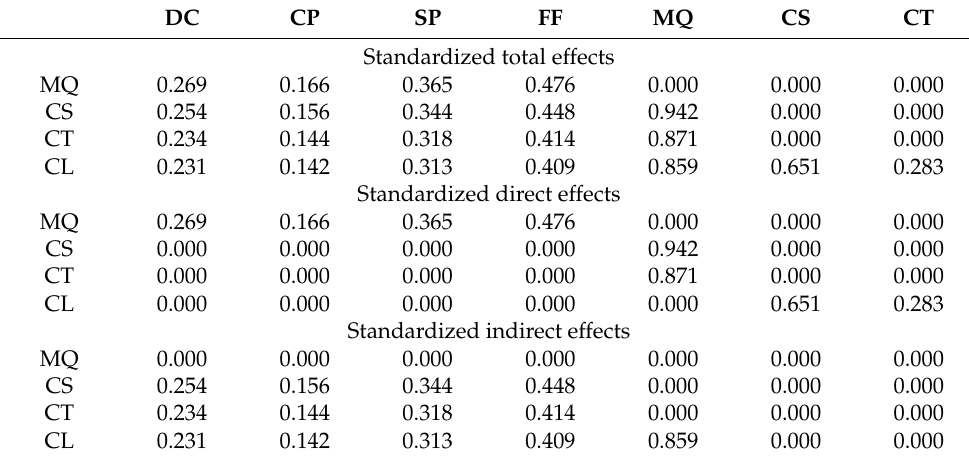
Table 8. The standardized total, direct, and indirect effects registered between the variables of the structural equations